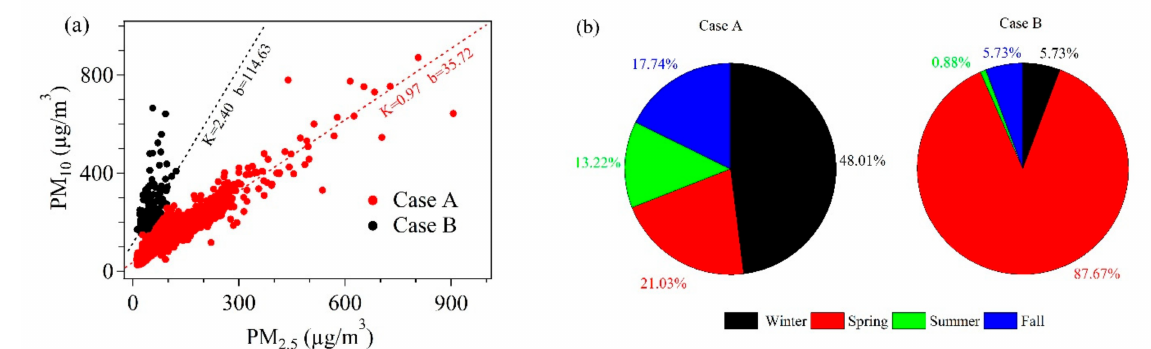
Figure 4. The scatter plots of the PM 10 and PM 2.5 was displayed in ( a ). Case B was divided under the condition that PM 10 did not meet the daily Grade II standard (150 µ g/m 3 ) and the ratio of PM 10 /PM 2.5 was greater than 2.7. The remaining part is Case A. ( b ) The pie charts show the percentages of the two Cases in different seasons.